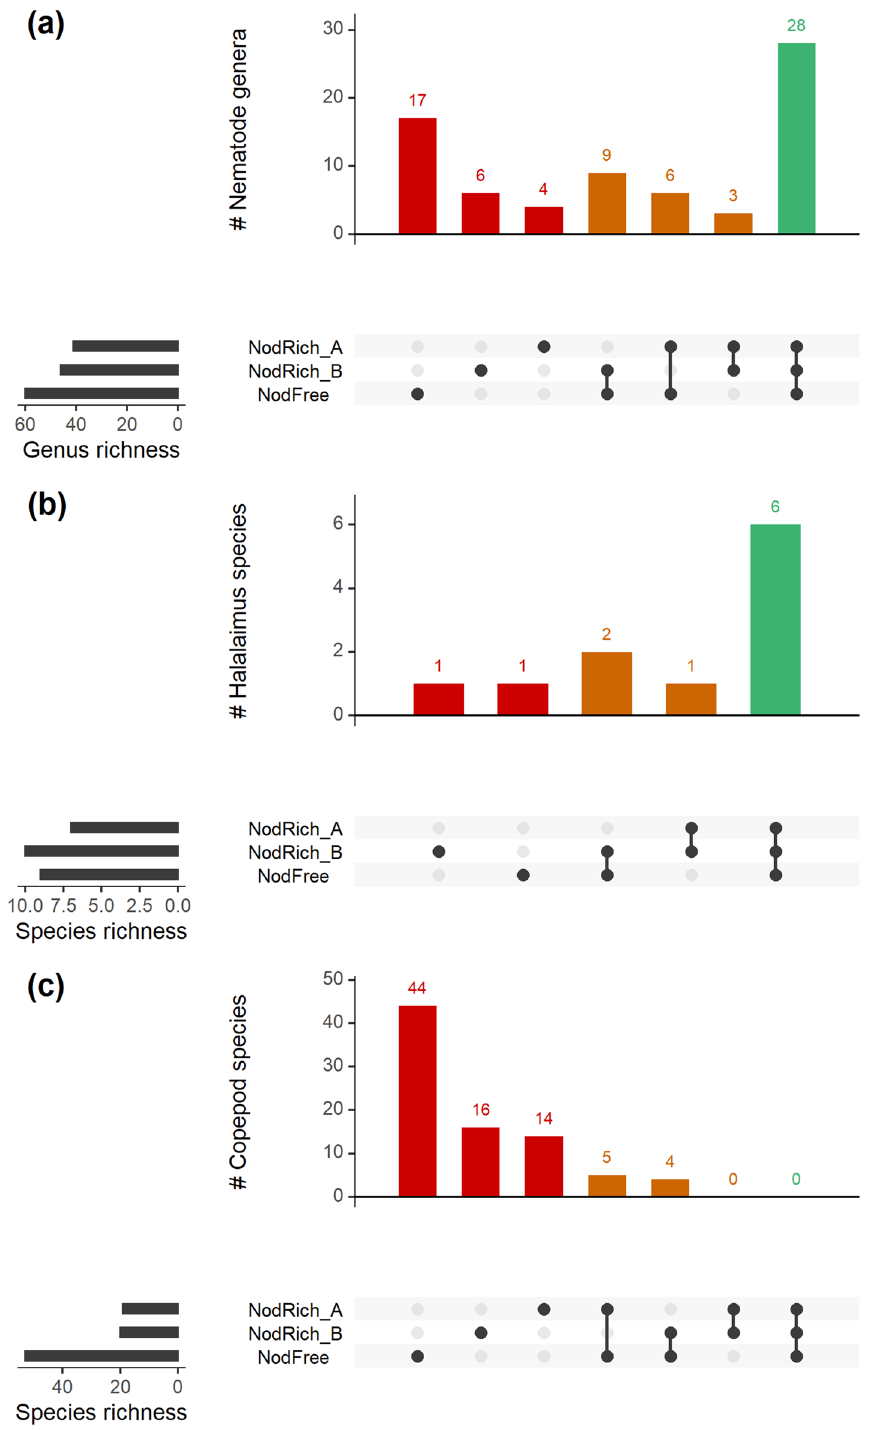
Figure 4. UpSet plots for the nodule-free (NodFree) and nodule-rich stations (NodRich_A and NodRich_B) showing the number of shared and unique taxa. ( a ) Nematode genera, ( b ) Halalaimus species and ( c ) copepod species. The color of the bars denotes the commonness of taxa, with red: unique taxa, yellow: taxa shared between two stations, green: taxa shared between all three